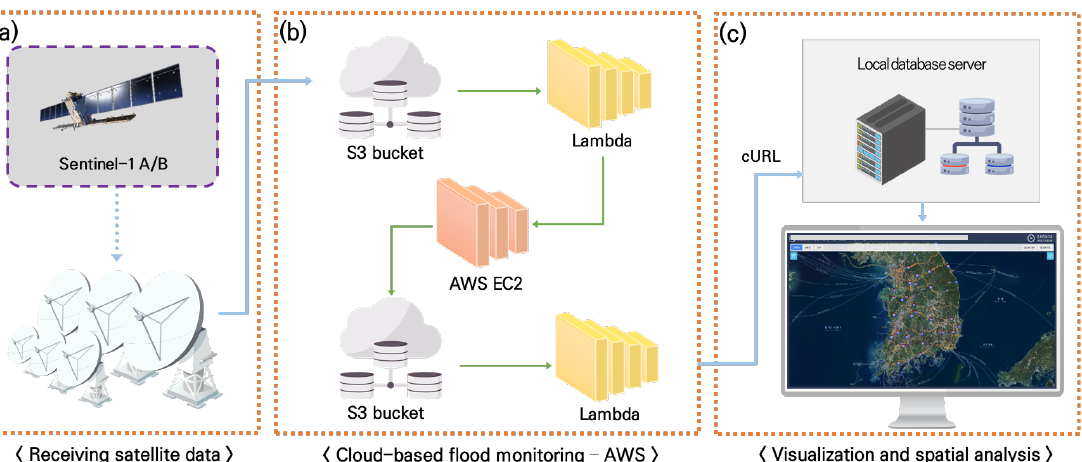
Figure 1. Processing chain for fully automated waterbody extraction for regular flood monitoring: ( a ) receiving satellite data, ( b ) deep learning-based flood area extraction on Amazon Web Services (AWS), and ( c ) visualization and spatial analysis.